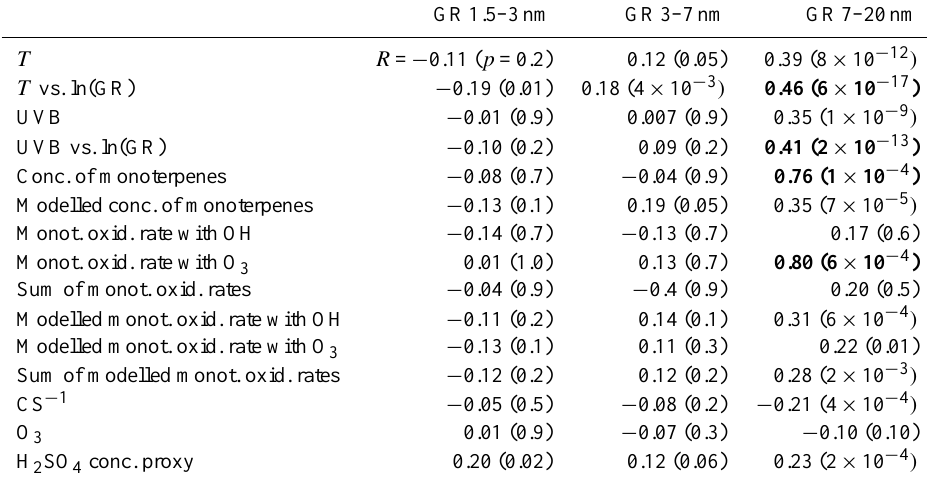
Table 4. Correlation coefficients R (and p-values) between growth rates of the particles in the size ranges 1.5–3nm, 3–7nm and 7–20nm and the meteorological variables, gas concentrations and condensation sink. For monoterpene concentration and oxidation rates of monoterpenes, as well as for modeled monoterpene concentration and modelled oxidation rates of monoterpenes event time (time period of growth from 1.5nm to 20nm) median values were used. Otherwise, median values from the growth time in each size range were used. Correlations with R > 0.40 are indicated in